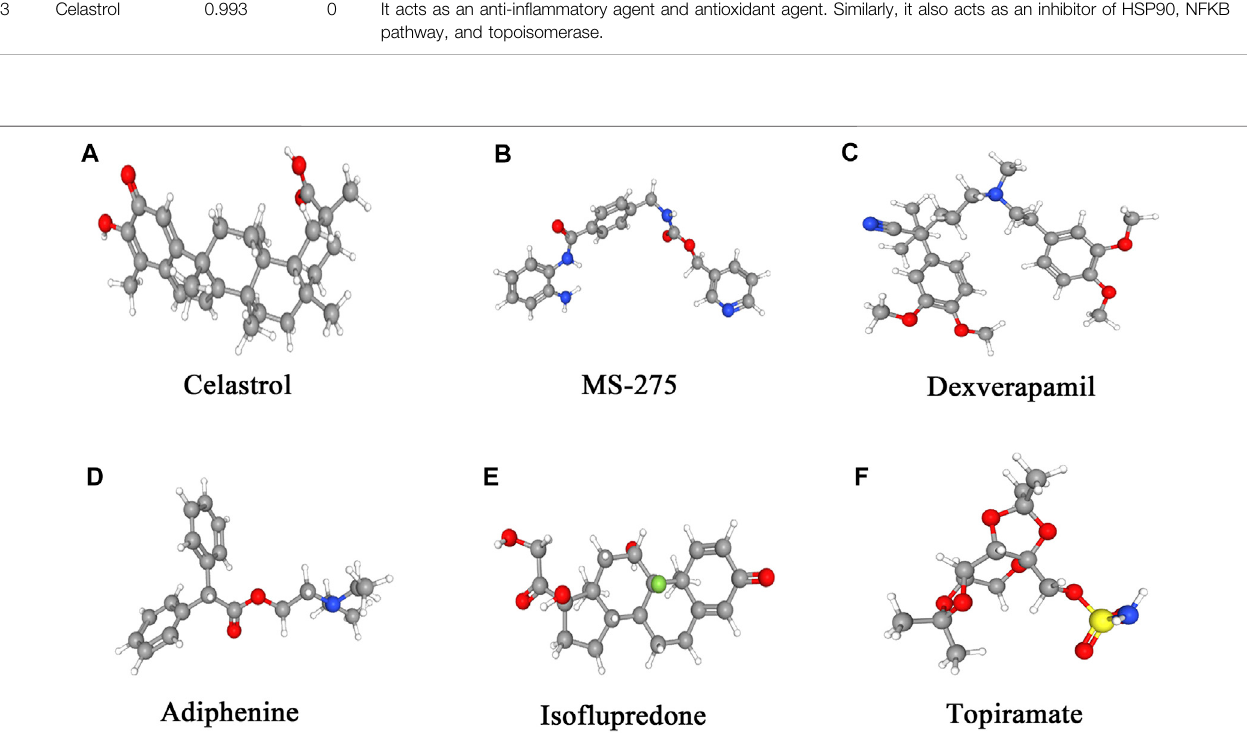
FIGURE 7 | 3D conformers of the top six candidate therapeutic agents with the highest absolute enrichments. For the identi fi cation of small molecules, the DEGs and Broad Institutes Connectivity Map (cMAP) database (https://portals.broadinstitute.org/cmap) were used, and the connectivity cutoff value used was > 0.8. Molecules with the highest absolute enrichment values, namely, those that are strongly associated with the DEGs, indicate their potential therapeutic effects on EM.